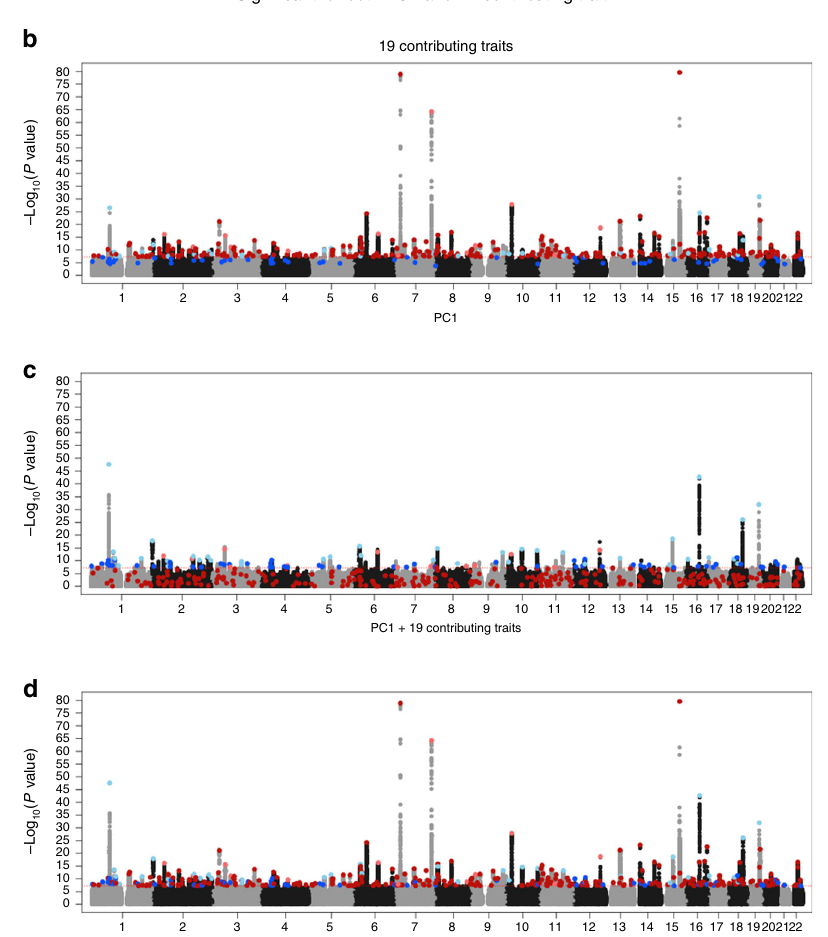
Fig. 3 Manhattan plot of PC1 and its 19 signi fi cantly contributing single food intake QT. a Schematic depiction of four groups of signi fi cant loci (and corresponding b , c Manhattan plot colors) for various combinations of PC1 and its 19 contributing traits. Fifty- fi ve loci signi fi cant for PC1 only (dark blue), 282 loci signi fi cant for one or more of the 19 contributing FI-QTs only (dark red), 37 loci more signi fi cant for PC1 (light blue), and 13 loci more signi fi cant for one or more of the 19 FI-QTs (light red). b Combined Manhattan plot of the minimum P value across the 19 FI-QTs that signi fi cantly contribute to PC1. c Manhattan plot of PC1 only. d Combined Manhattan plot of the minimum P value across PC1 and the 19 13 loci more signi fi cant for one or more of the 19 QTs (light red). The 55 loci signi fi cantly associated with PC1 but not FI-QTs still trend toward association with one or more of the 19 contributing FI-QTs, whereas the reciprocal is not always the case: some FI- QT-associated SNPs display no association with PC1 at all. This observation indicates that the use of PCs can increase power to detect some associations, while others are only detectable through association with speci fi c foods, supporting the use of both of these complementary phenotyping approaches to more effectively de fi ne the genetic architecture of dietary intake.